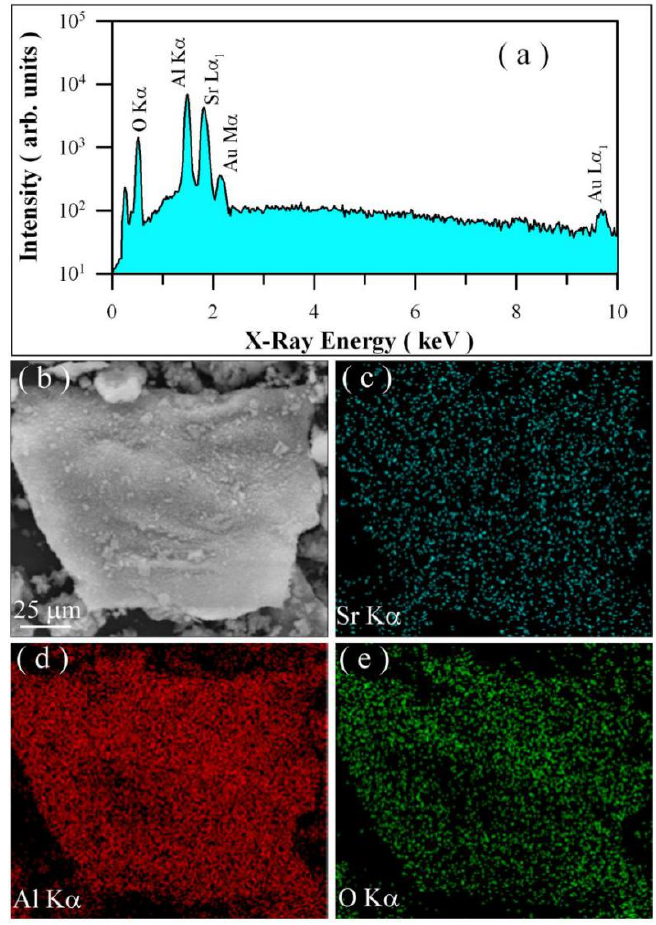
Figure 3. EDX spectrum and elemental mapping of undoped SrAl 2 O 4 phosphors: ( a ) EDX spectrum; ( b ) electronic image of the selected area for elemental mapping; ( c ) Sr map; ( d ) Al map; and ( e ) O map.